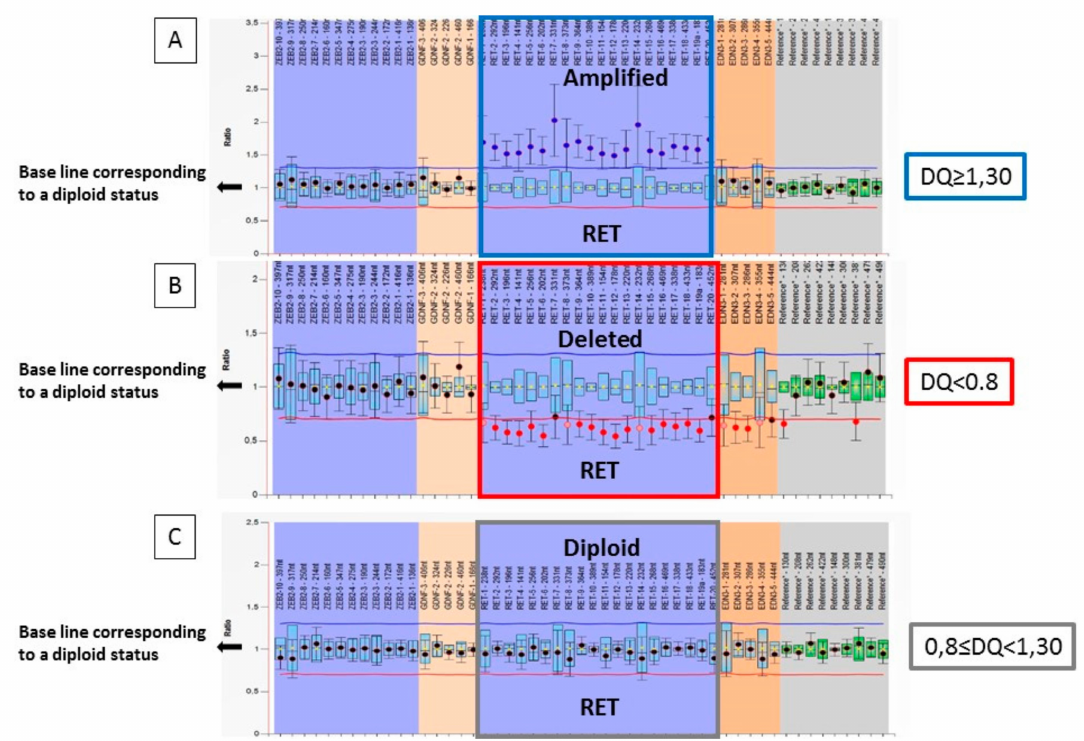
Figure 1. Graphic representation of the RET ploidy analyzed by Multiple Ligation Probe Amplification (MLPA) technique: ( A ) Probe signals are above the baseline indicating RET gene amplification; ( B ) Probe signals are below the baseline indicating RET gene deletion; ( C ) Probe signals are within the baseline indicating the presence of 2 copies of the RET gene.